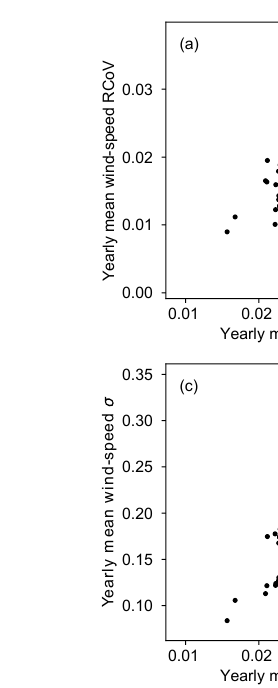
Figure A2. As in Fig. 6, but the metrics are calculated using yearly mean wind